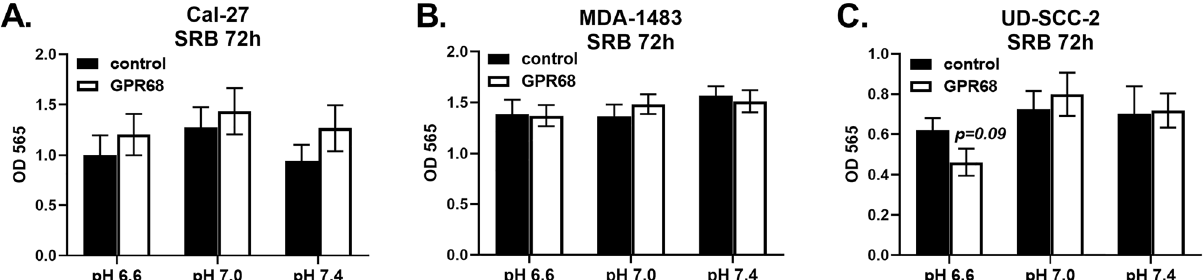
Figure 7. GPR68 knockdown had no significant effect on cell line growth. Cal-27 ( A ), MDA-1483 ( B ) and UD-SCC-2 ( C ) cells were cultured for 72 h with siRNA specific for GPR68 (open bars) or a negative control (closed bars), as indicated. An SRB assay was used to measure cell growth, with data reported as the mean +/− SEM of the optical density at 565 nm. Data are combined from 4 experiments with n = 16 ( A ), 3 experiments with n = 14 ( B ) or 3 experiments with n = 12 ( C